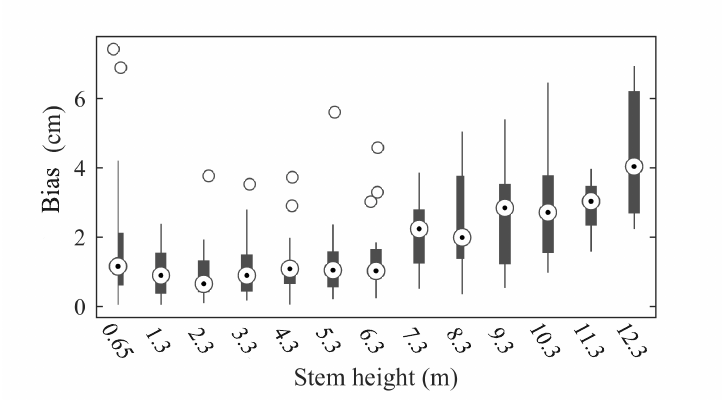
Figure 12. Bias of stem location estimation and its distribution with height. Results are evaluated from all trees.